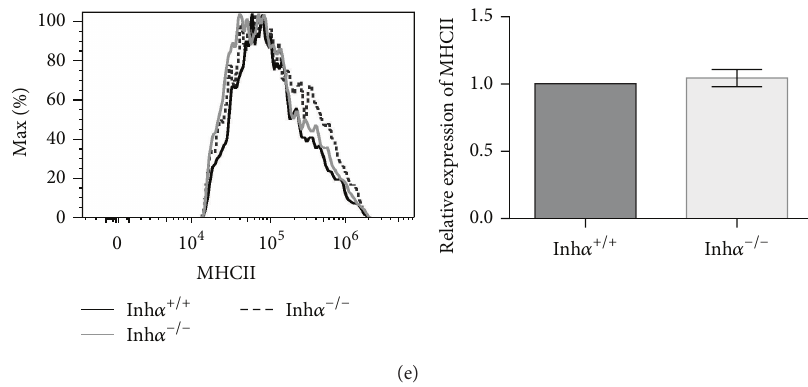
Figure 3: In Inh 𝛼 −/− mice absolute pDCs numbers are diminished in thymus, while other hematopoietic derived stromal cells do not show alterations (macrophages). (a) Representative dot plots of the strategy used to analyze pDCs; from total thymus an initial gate of CD11c med MHCII lo cells was used (a, left) followed by a region in CD45R/B220 + cells (a, right). (b) Graphs represent the percentages and total numbers of thymic pDCs identified as CD11c med MHCII lo CD45R/B220 + cells. (c) Expression of MHCII on pDCs. MFI was determined and relative expression calculated as in Figure 2. For pDCs, Inh 𝛼 +/+ , 𝑛 = 6 and Inh 𝛼 −/− , 𝑛 = 7 were analyzed. (d) Analysis of macrophages was performed using a CD45 + gate, followed by MHCII + F4/80 + detection. Percentages and absolute numbers are shown. (e) A representative histogram showing the MHCII expression in macrophages of Inh 𝛼 +/+ and Inh 𝛼 −/− mice (left panel); for each histogram two Inh 𝛼 −/− (gray and dashed lines) and one Inh 𝛼 +/+ mice (black line) were represented and the summary of data showing the relative expression of MHCII in macrophages (right panel) is shown. For macrophages, Inh 𝛼 +/+ , 𝑛 = 3 and Inh 𝛼 −/− , 𝑛 = 6 were used. Statistical significance: ∗ 𝑃 ≤ 0.05